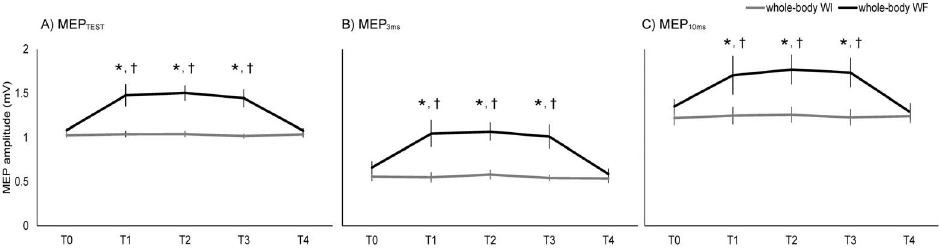
Figure 5. Changes in MEP amplitude for each intervention. MEP TEST , MEP 3 ms , and MEP 10 ms were induced by the test stimulus (TS) alone, after conditioning stimulus (CS) by TMS at ISIs at 3 and 10 ms, respectively. Asterisks (*) indicate significant differences (p , 0.05) compared with T0. Daggers ( { ) indicate significant differences (p , 0.05) compared with T4.